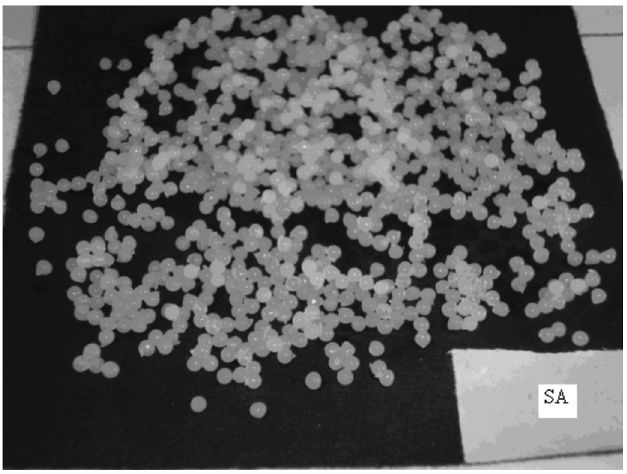
FIGURE 1 - Spherical shape of beads prepared with sodium alginate (SA) alone.